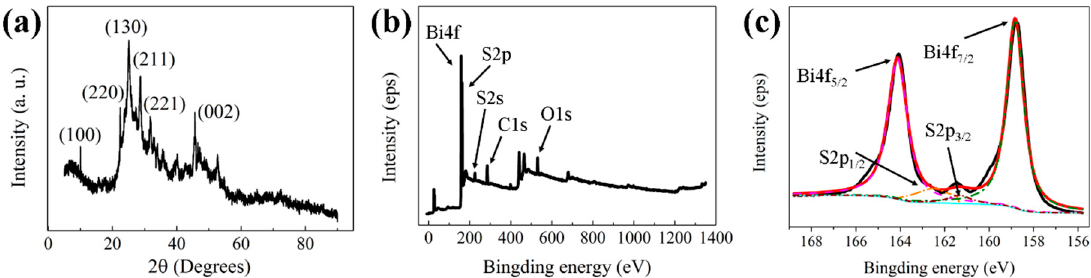
Figure 1. ( a ) XRD spectra of the graphene oxide (GO)/Bi 2 S 3 NPs, ( b ) XPS survey spectra of the GO/Bi 2 S 3